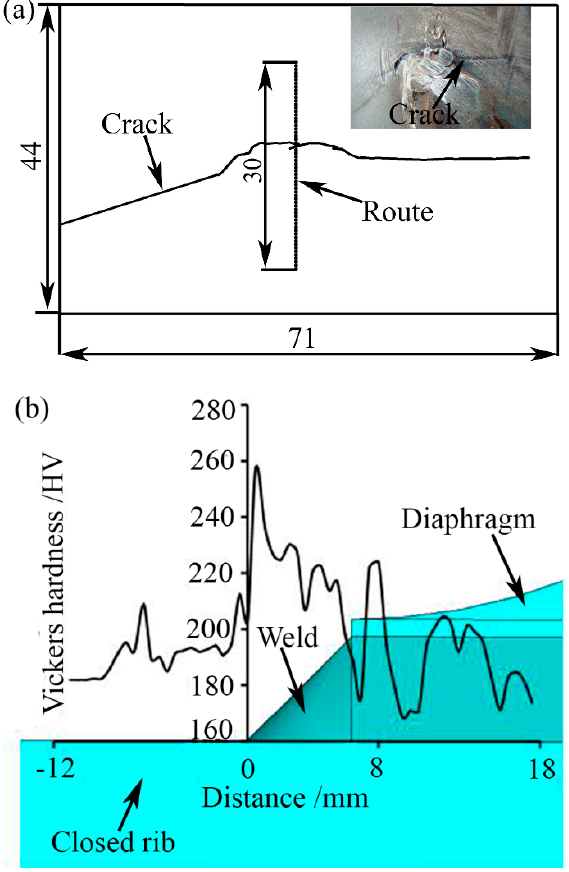
Figure 12. Vickers hardness test: ( a ) Sliced specimen (in mm) and ( b ) hardness distribution along the route.